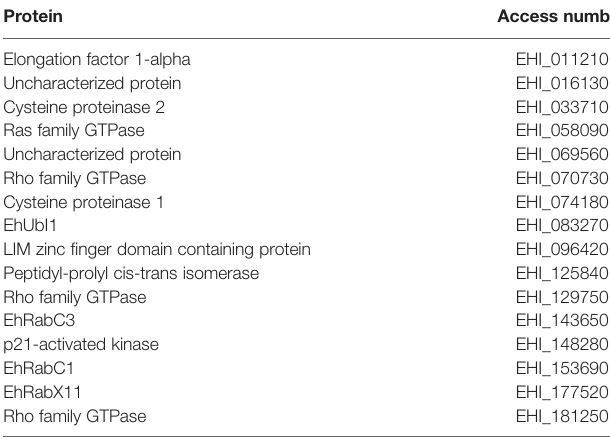
TABLE 1 | Proteins associated with vesicular traf fi cking. Protein TABLE 2 | Proteins associated with phagocytosis*.